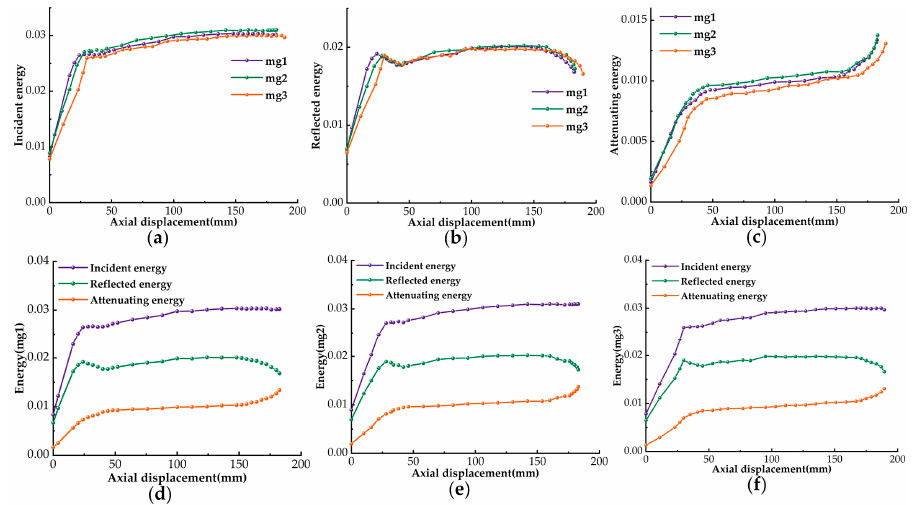
Figure 10. The stress wave energy change curve during bolt tension. ( a ) Incident energy change curve; ( b ) Reflected energy change curve; ( c ) Attenuated energy change curve; ( d ) mg1 energy change curve; ( e ) mg2 energy change curve; ( f ) mg3 energy change curve.